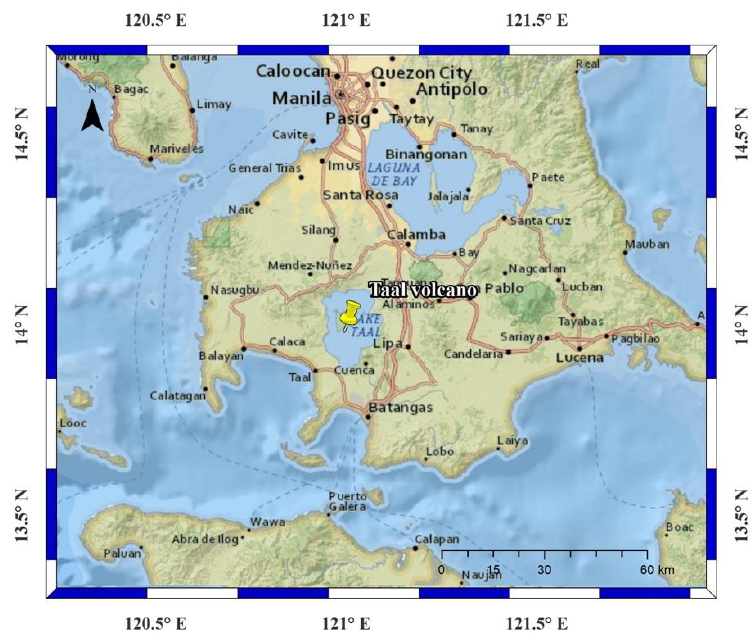
Figure 1. Geographical location and surrounding environment of the Taal volcano (Source of the base map: National Geographic).